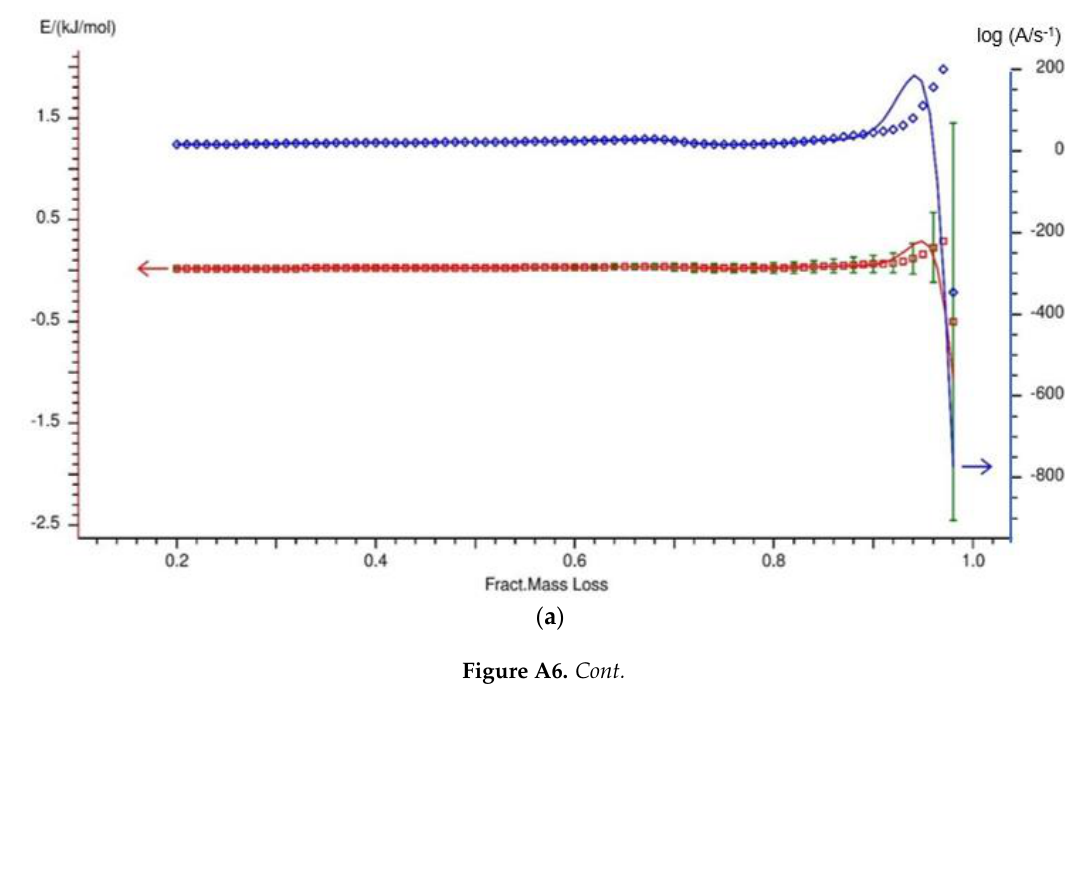
Figure A5. Activation energy (Red color) and pre-exponential coefficient (Blue color) as a function of the degree of reaction determined by the Friedman method for pine wood. Green color represents the statistical error.